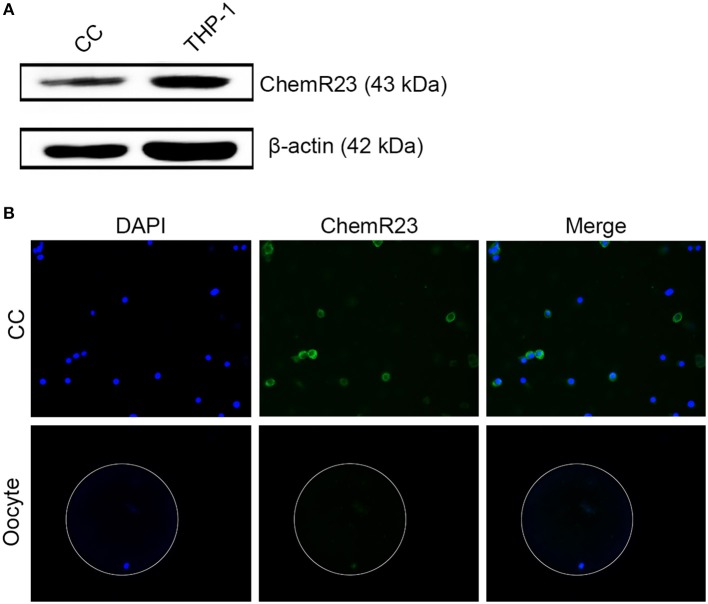
Identification of RvE1's receptor on cumulus cells (CCs) and oocytes. (A) Detection of ChemR23 expression on CCs by western blot. THP-1 as a positive control; β-actin as the internal reference. Three independent biological replicates. (B) The presence of ChemR23 (green) on CCs and oocyte was analyzed by fluorescence microscope. The nuclei of CCs and oocyte were stained with DAPI (blue). The outside silhouette of oocyte was presented by a white ring manually. Three independent biological replicates.